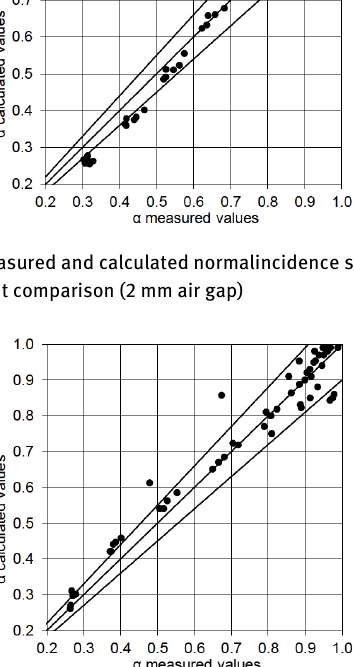
ϵ value is 5.0%. Using the same set of data, the fraction of data predicted to within ±10% is calculated to be 82%, 80% and 81% respectively for no air gap, an air gap and all data set. This analysis confirmed the modeling effectiveness in simulating the effect of perforated facings on the acoustical behaviour of absorbing